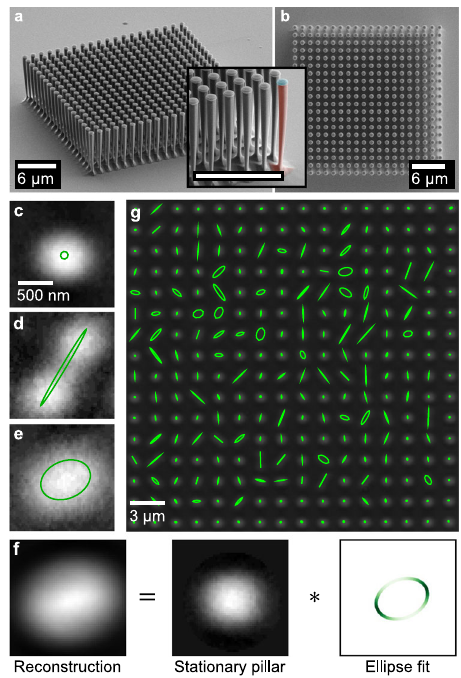
Fig. 1 Characterization of the sample and spatially resolved imaging of vibrational motion. a , b Scanning electron micrographs of a 20 × 20 nanopillar array with lattice constant 1.4 μ m, pillar diameter d ≈ 300 nm (measured at the bottom), height H ≈ 6.5 μ m and taper angle φ ≈ 1. 5 ∘ in a 60 ∘ tilted view and in top view. The inset in a shows a zoom of the array corner in the tilted view. False-colors on a single pillar indicate the inverted conical GaAs pillar (red) and the SiO 2 etch mask (blue). c – e show top view images of three different pillars (extracted trajectories added in green) differentiating between c a pillar at rest and vibrating pillars with d linear trajectory and e elliptical trajectory. f Visualization of the convolution equation. The reconstructed moving pillar image (here, shown for the pillar in e ) is a convolution (denoted by *) of the stationary (non-driven) pillar image and the time-average of the fi tted elliptical trajectory; details can be found in Supplementary Note 2 and Supplementary Figs. 2 and 3. g Top view of the 16 × 16 central pillars of the array in a driven at Ω = 2 π × 1.3694 MHz including trajectories (green). The outermost two rows are omitted